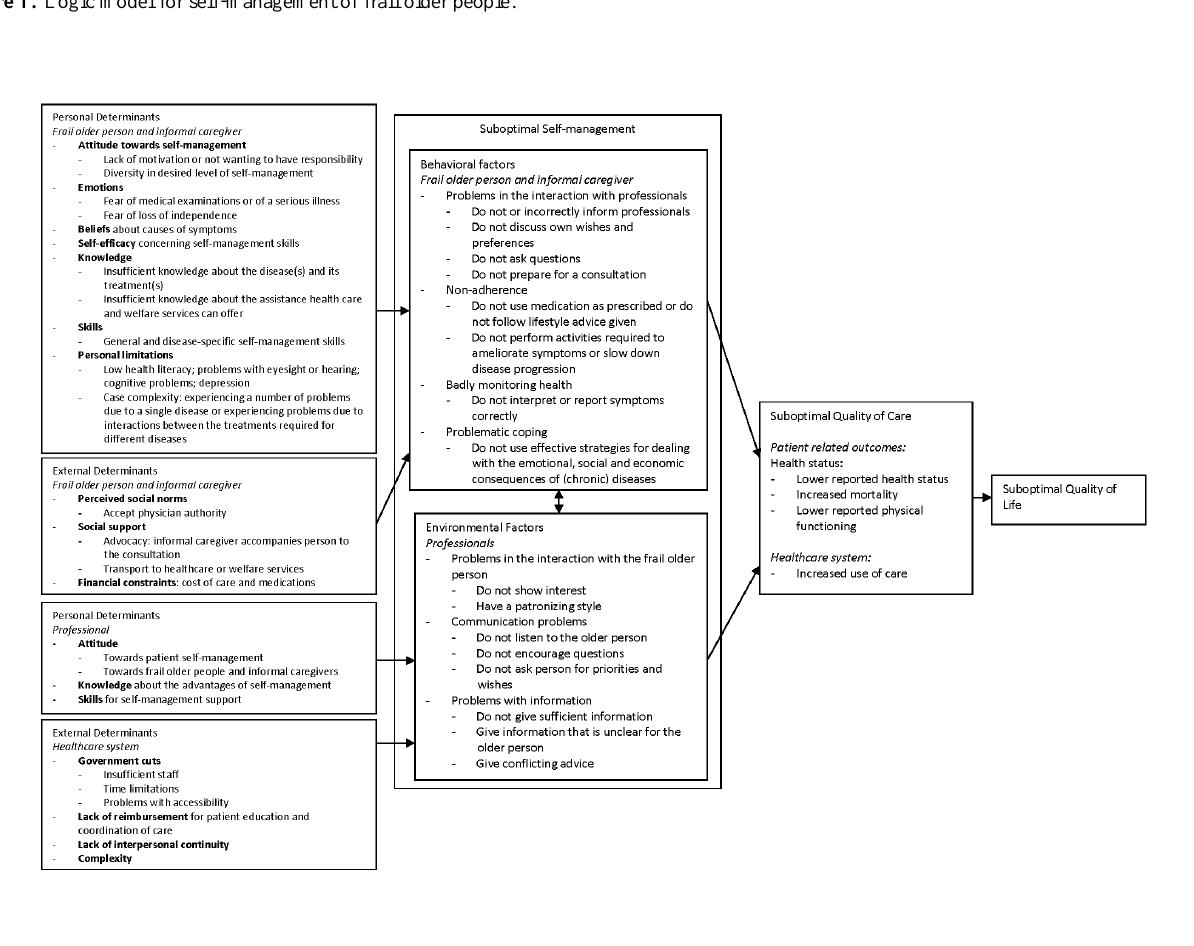
Figure 1. Logic model for self-management of frail older